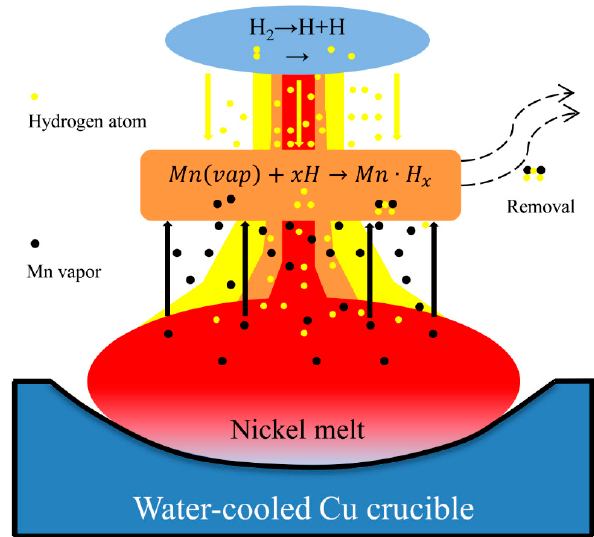
Figure 8 Schematic diagram of manganese removal from nickel melt during HPAM. Figure 8. Schematic diagram of manganese removal from nickel melt during